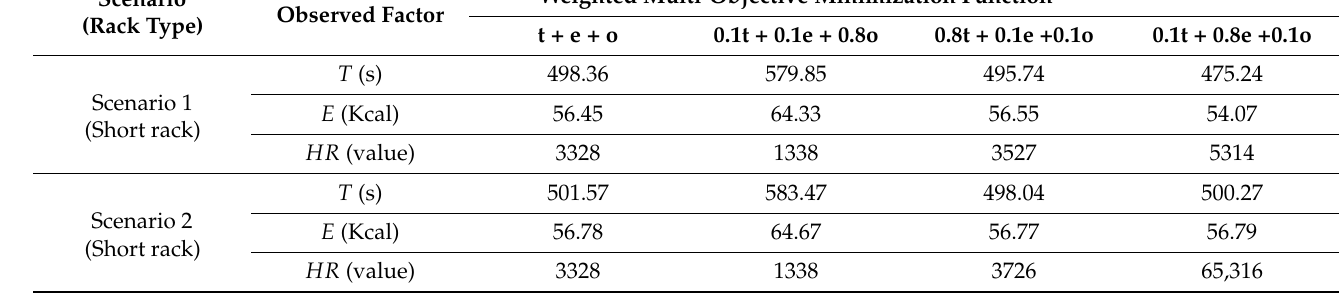
Table 8. Comparison of results for different scenarios, rack type, and minimization based on differently weighted multi- objective